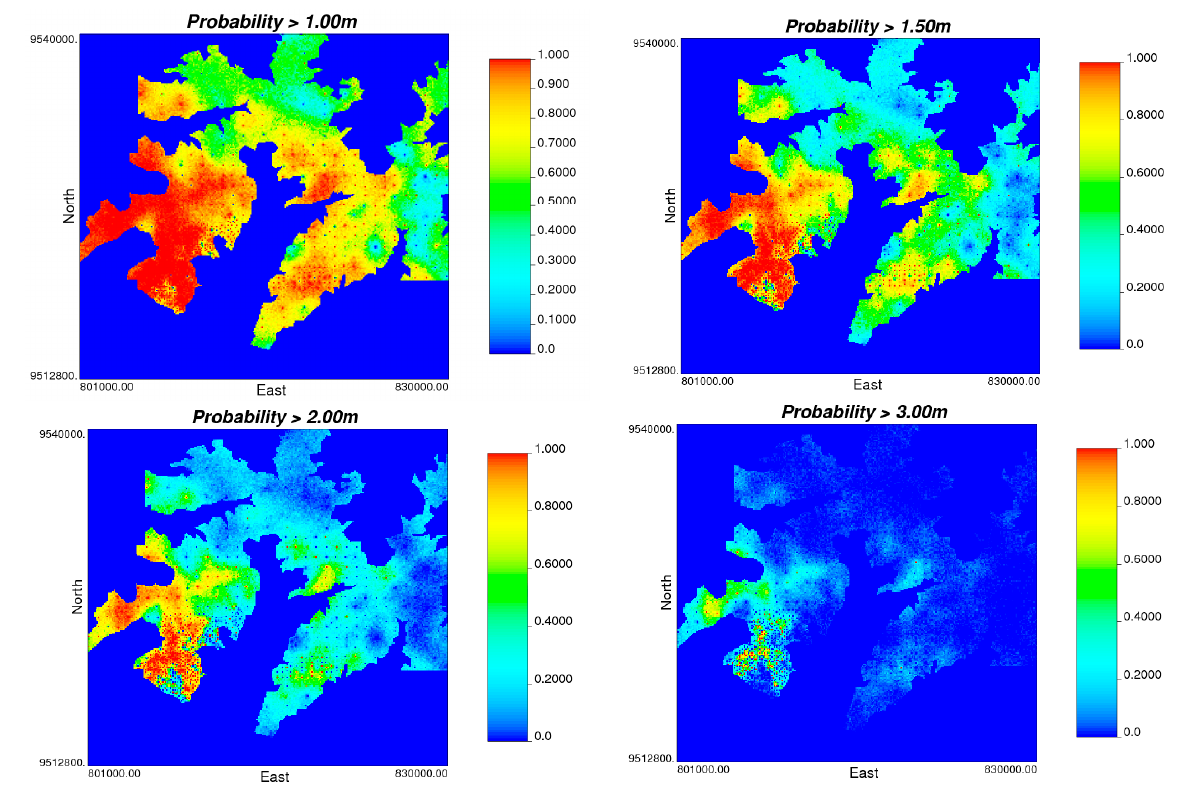
Figure 14. Probability maps with cutoffs of 1.00, 1.50, 2.00, and 3.00 m.